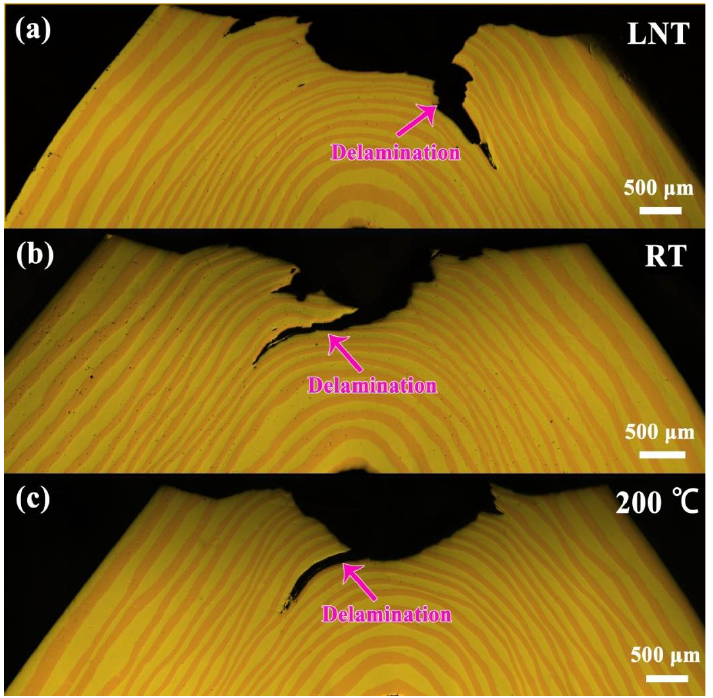
Figure 7. ( a – c ) The cross-sectional optical images of the multilayered copper–brass blocks impacted at LNT, RT, and 200 °C, respectively. It is noted that the cross-section is selected in the mid-plane along the thickness direction.